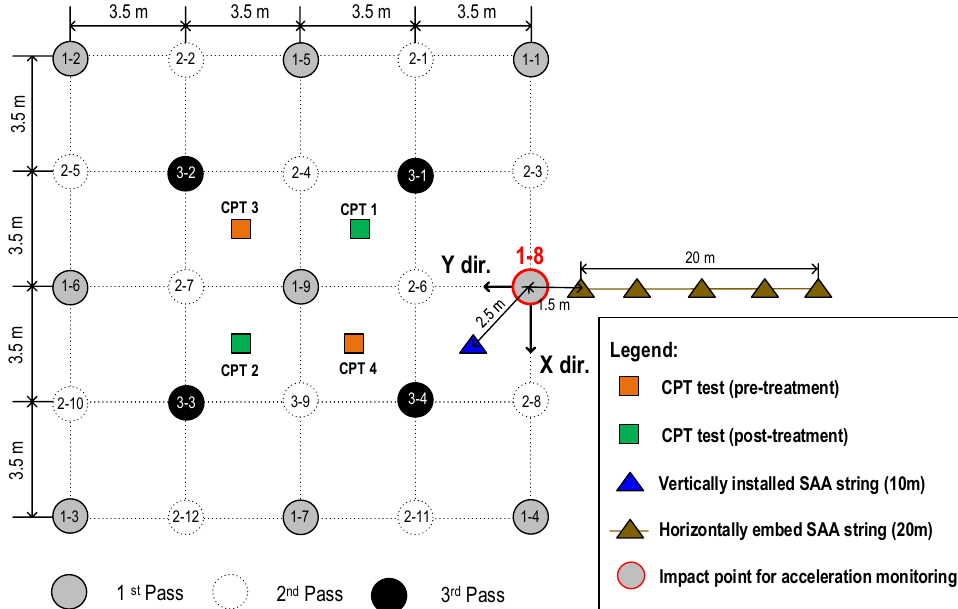
Figure 6. Locations of the CPT investigation test, SAA string measurement, and monitoring impact point as well as the layout of the RIC sequence and grid pattern (in X–Y